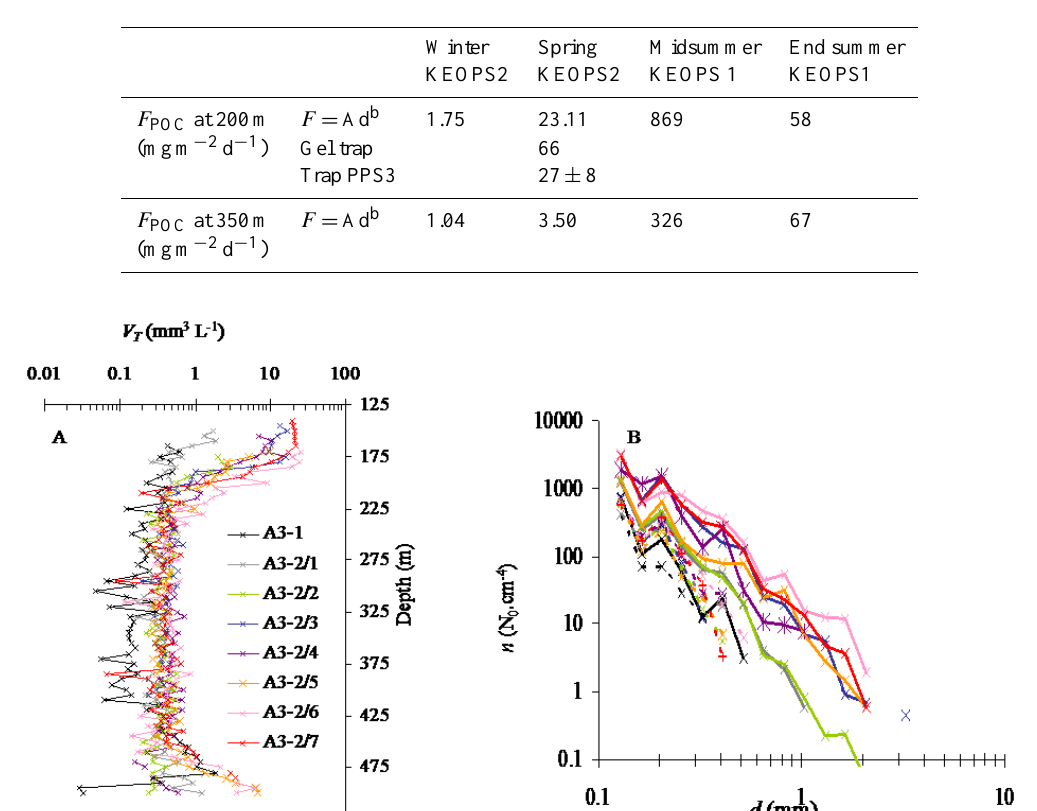
Figure 7. Distribution of V T below the surface mixed layer (A) . Normalized particles size spectra abundance average over the 320–350m layer (dotted line) and 100–200m layer (solid line) (B)